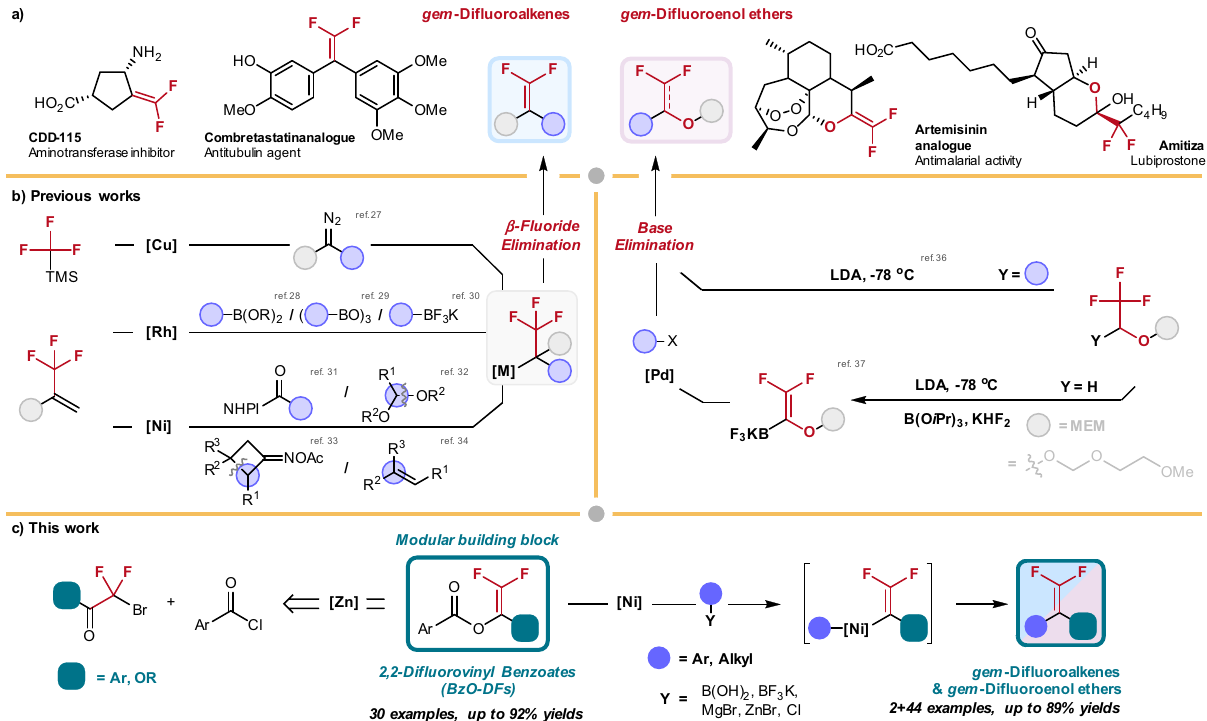
Fig. 1 Cross-coupling approaches toward gem- di fl uoroenol ethers and gem- di fl uoroalkenes synthesis. a Selected example of bioactive gem- di fl uoroenol ethers and gem- di fl uoroalkenes. b Conventional synthetic approaches for gem- di fl uoroenol ethers and gem- di fl uoroalkenes synthesis rely on β - fl uoride elimination and base elimination as key steps; this approach demands tedious preparation of the tri fl uoromethyl-substituted precursors. c This work presents a convenient synthesis of 2,2-di fl uorovinyl benzoates (BzO-DFs) by simple zinc reduction of abundant bromodi fl uoroacetates and bromodi fl uoroketones; the BzO-DFs serve as versatile building blocks for Ni-catalyzed cross-coupling reaction for modular synthesis of gem- di fl uoroenol ethers and gem- di fl